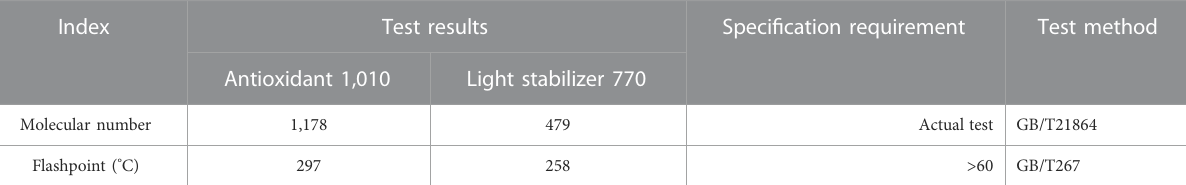
TABLE 5 Anti-aging